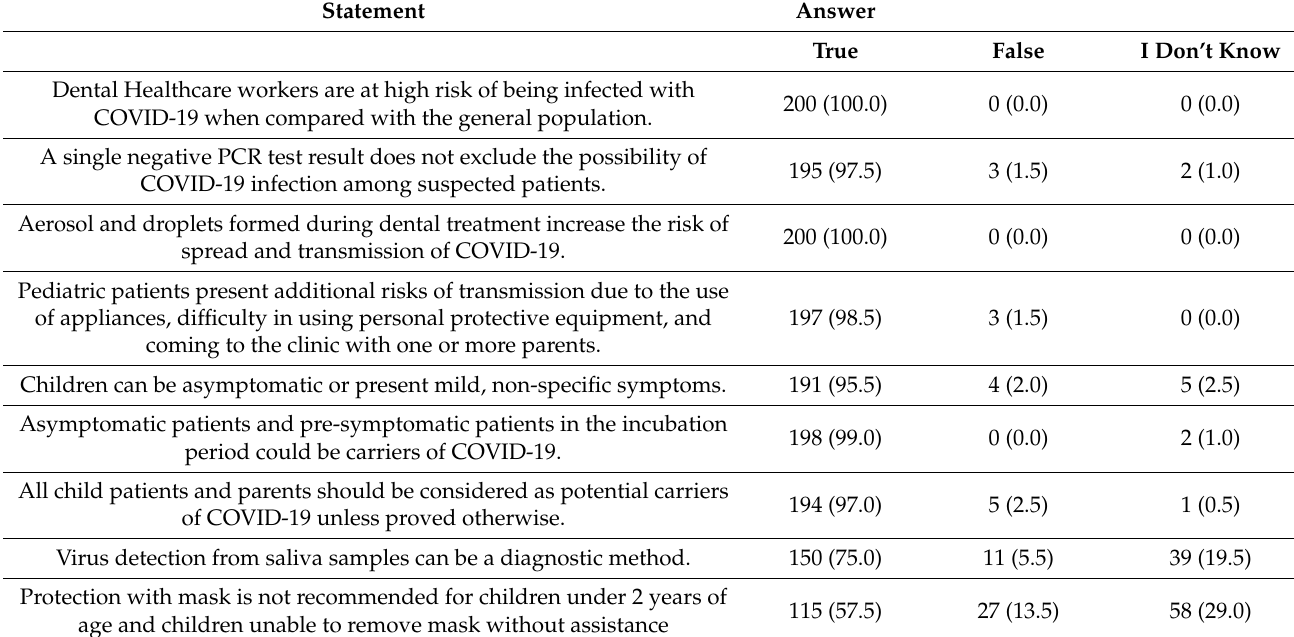
Table 4. Knowledge of participants related to the statements about COVID-19.